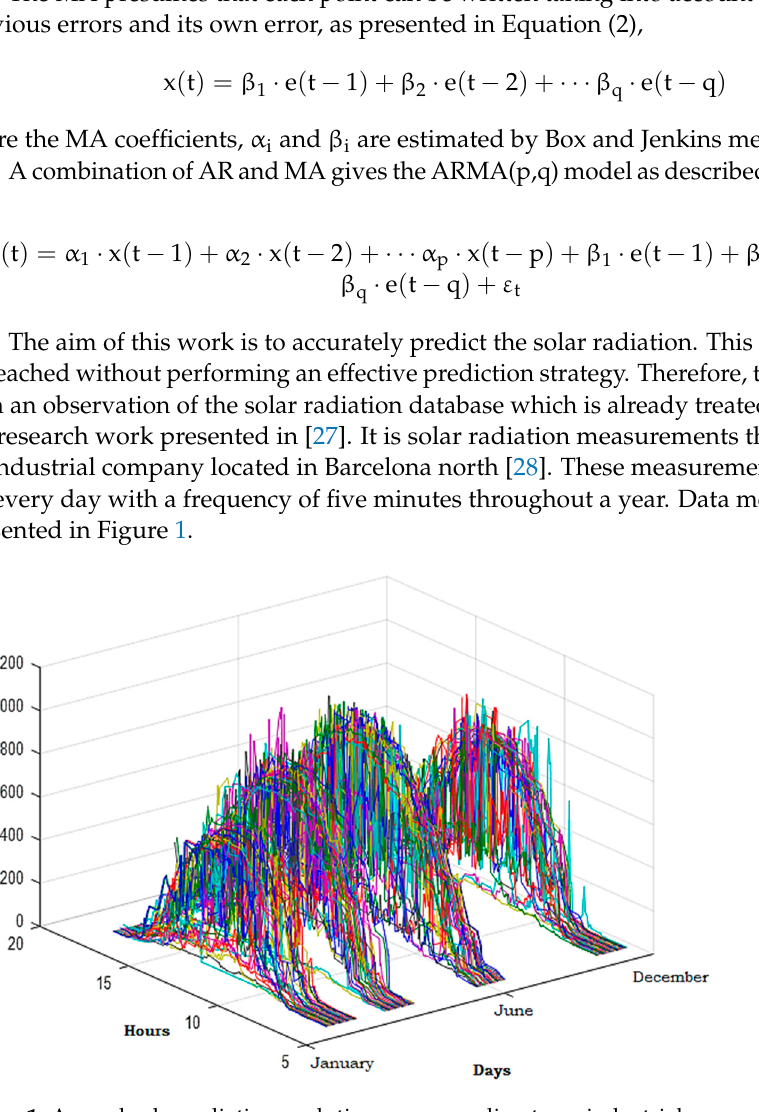
Figure 1. Annual solar radiation evolution corresponding to an industrial company in Barcelona.